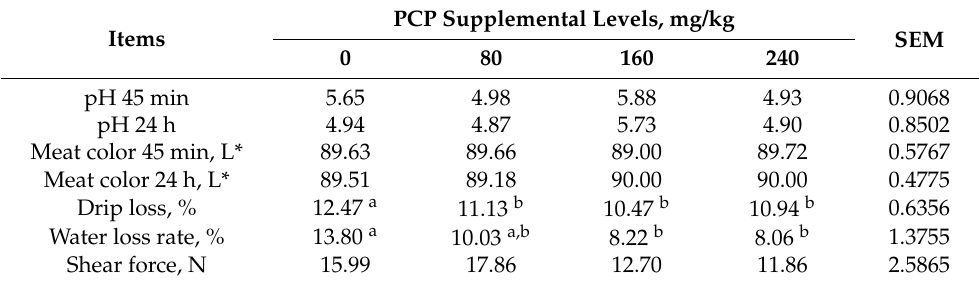
Table 4. Effect of anthocyanin-rich PCP on meat quality of growing chickens. Items